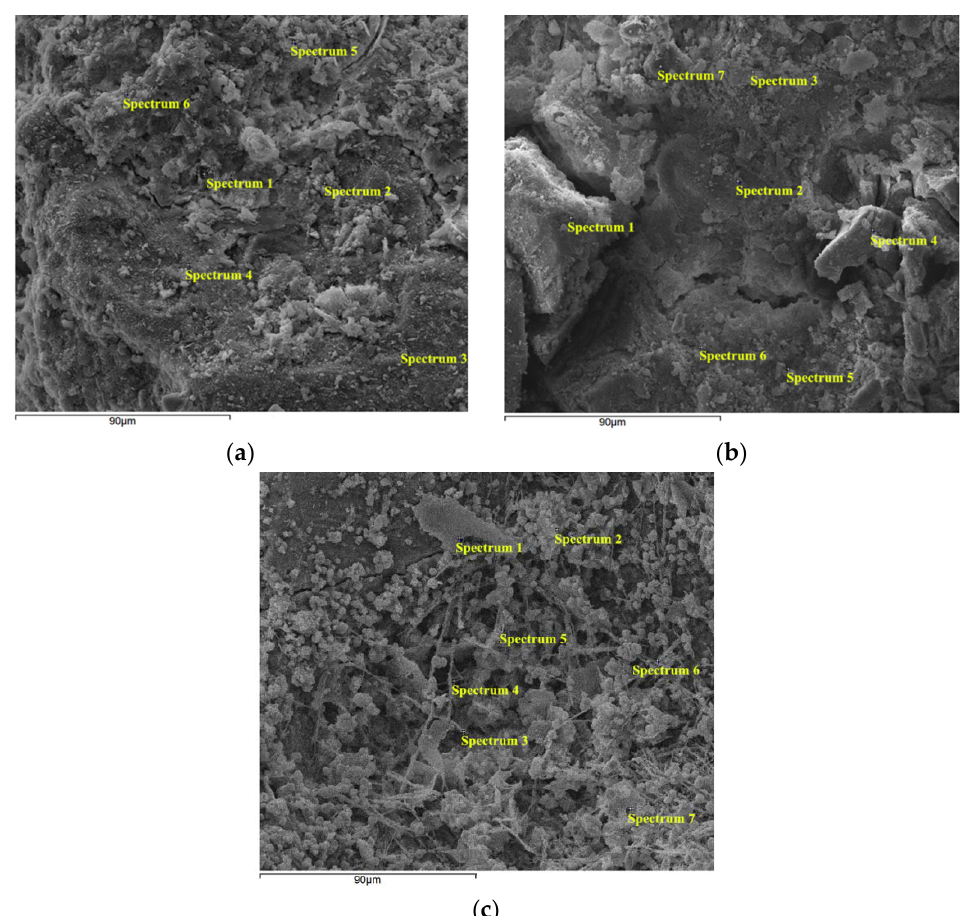
Figure 13. SEM of the carbonation layers of the samples with the selected spectral points for EDS analysis: ( a ) group AI (atmospheric environment), ( b ) group WB (water-immersion environment), and ( c ) group HA (saturated-humidity environment).